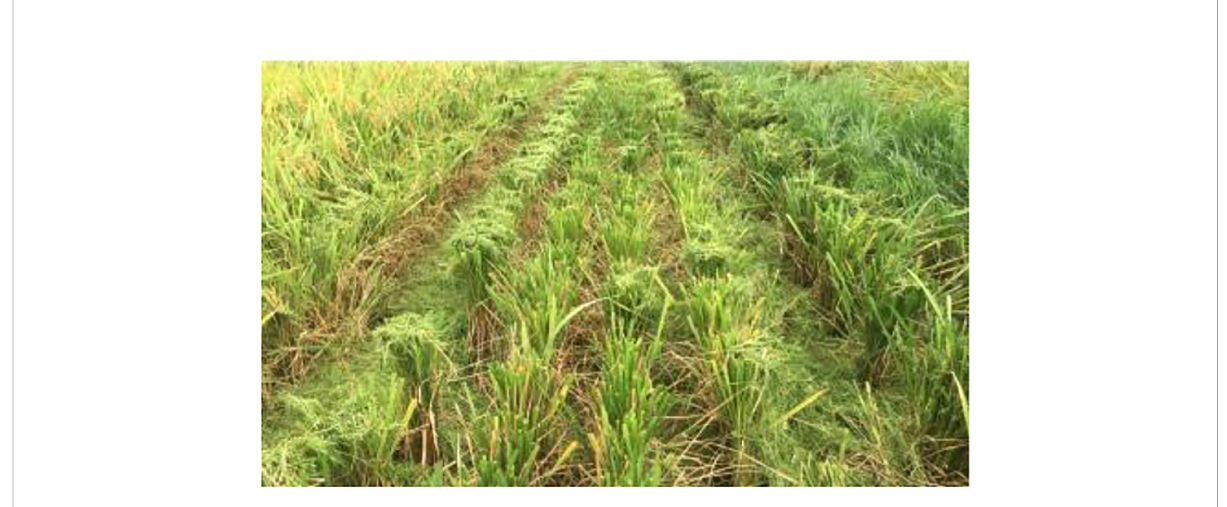
FIGURE 2 Rice stubble after fi rst-season